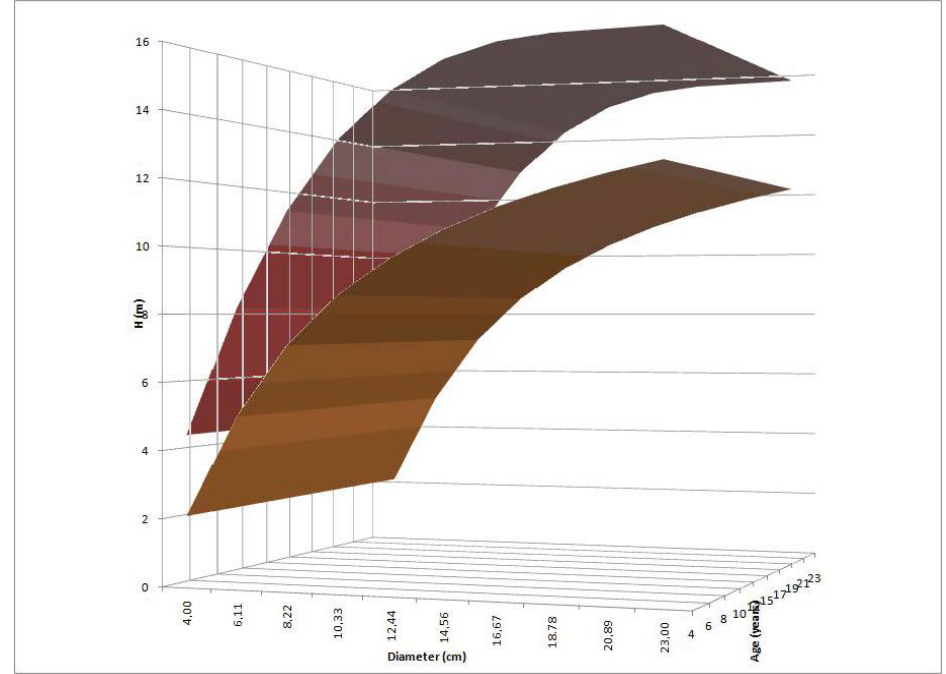
Figure 5. Total height estimation (upper surface) and bole height estimation (lower surface), with estimation surfaces developed from the selected total height–diameter and bole height–diameter models.